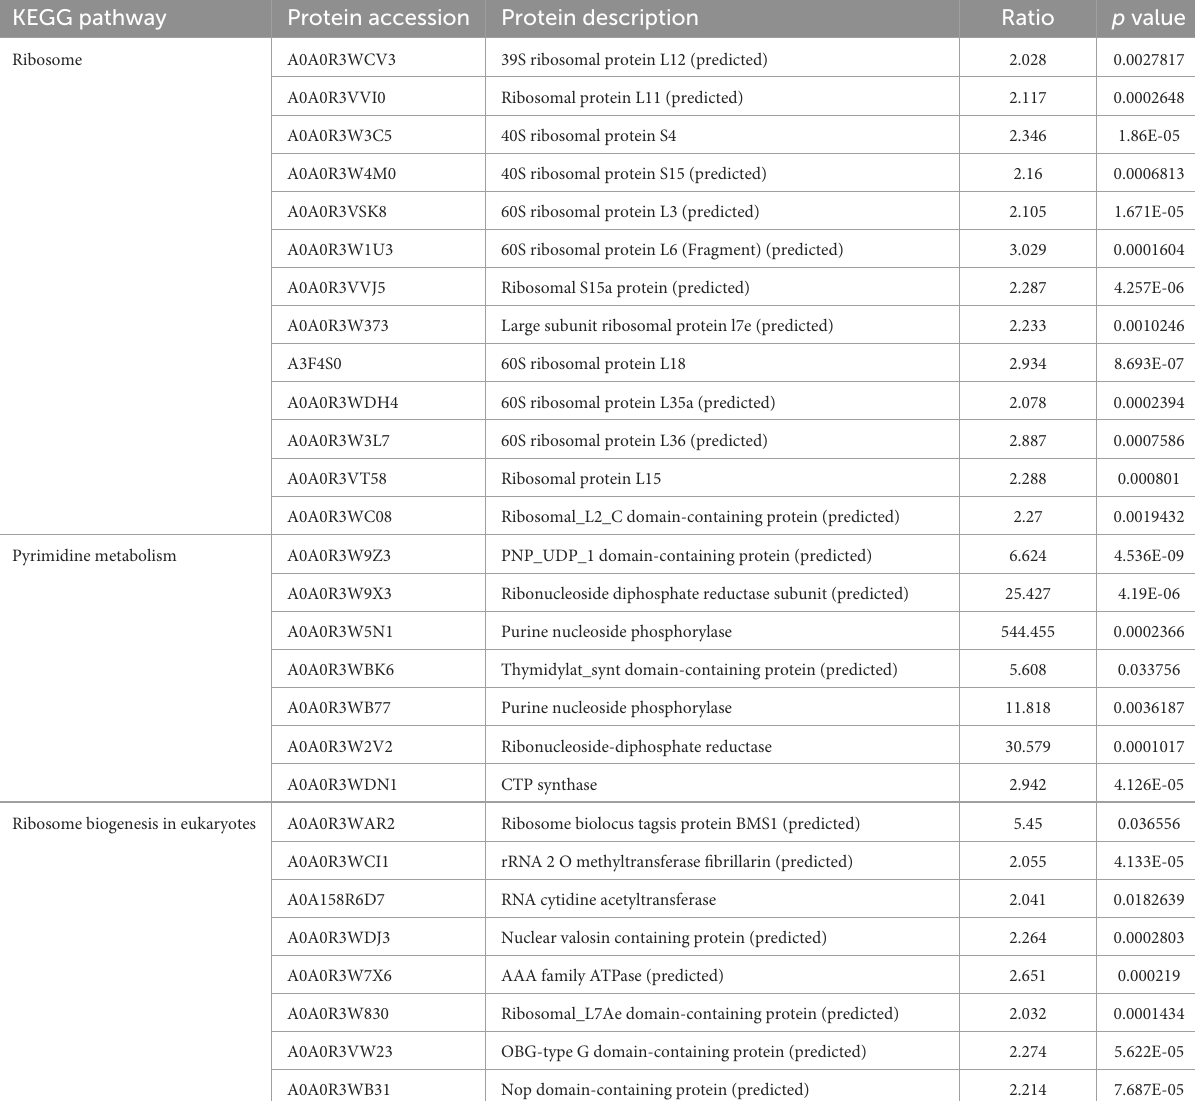
TABLE 4 KEGG enrichment of differentially expressed proteins in the adult stage. KEGG